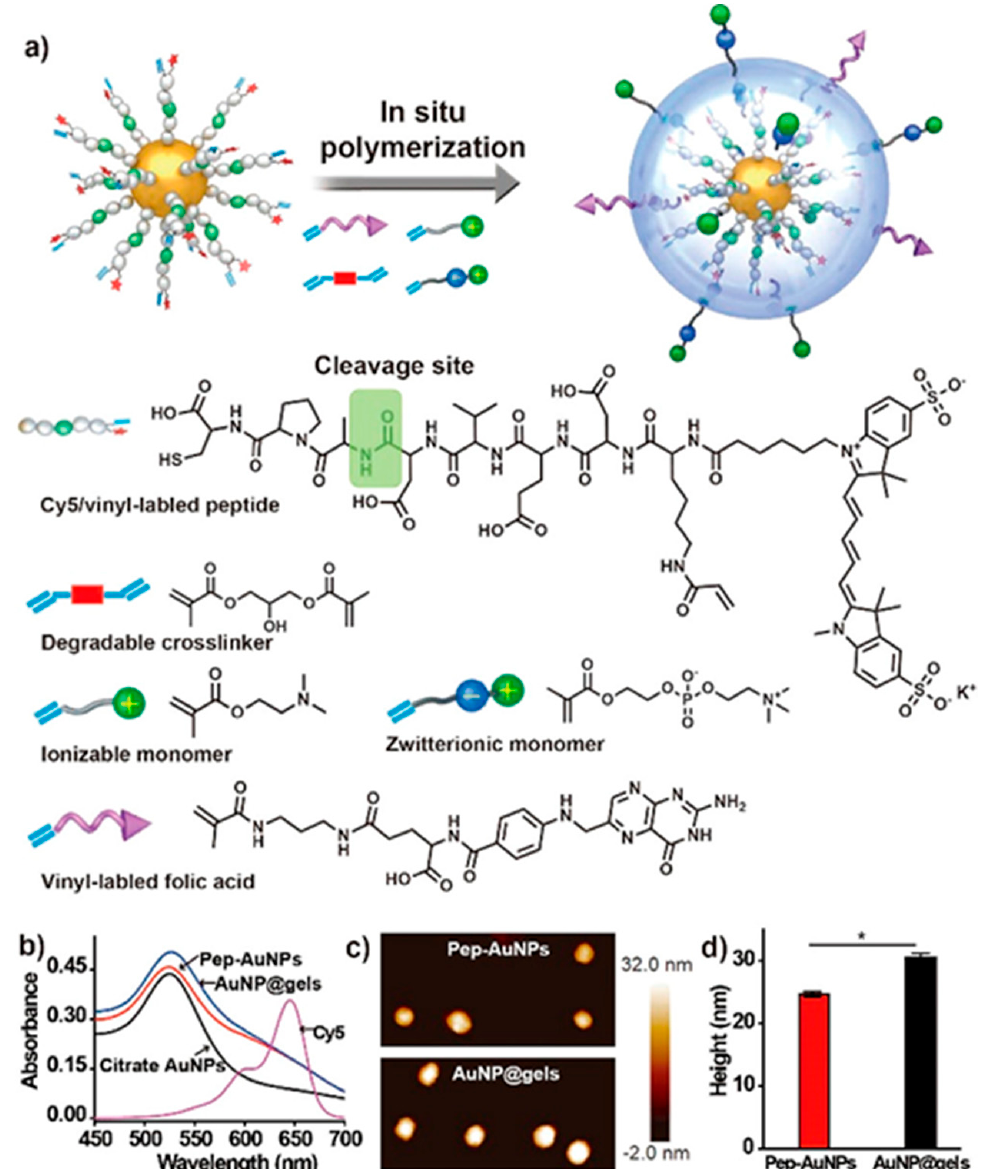
Figure 10. ( a ) Schematic illustration of the synthesis of a AuNP@gel probe through in situ polymerization of vinyl-bearing acid-degradable cross-linkers, ionizable monomers, zwitterion monomers, and cancer-cell-targeting vinyl-labeled folic acids on an AuNP core modified with Cy5 / vinyl-labeled CPADVEDK peptides. The green frame in the peptide sequence indicates the cleavage site for caspase-3 / -7. ( b ) UV / vis spectra of citrate-coated AuNPs, pep-AuNPs, AuNP@gels, and Cy5 dye solutions. ( c ) Atomic force microscopy (AFM) images of pep-AuNP (top) and AuNP@gel (bottom) probes. ( d ) Statistical sizes of pep-AuNP and AuNP@gel probes in part c (* p < 0.05). Reproduced with permission from Li, Q.; Qiao, X.; Wang, F.; Li, X.; Yang, J.; Liu, Y.; Shi, L.; Liu, D. Encapsulating a single nanoprobe